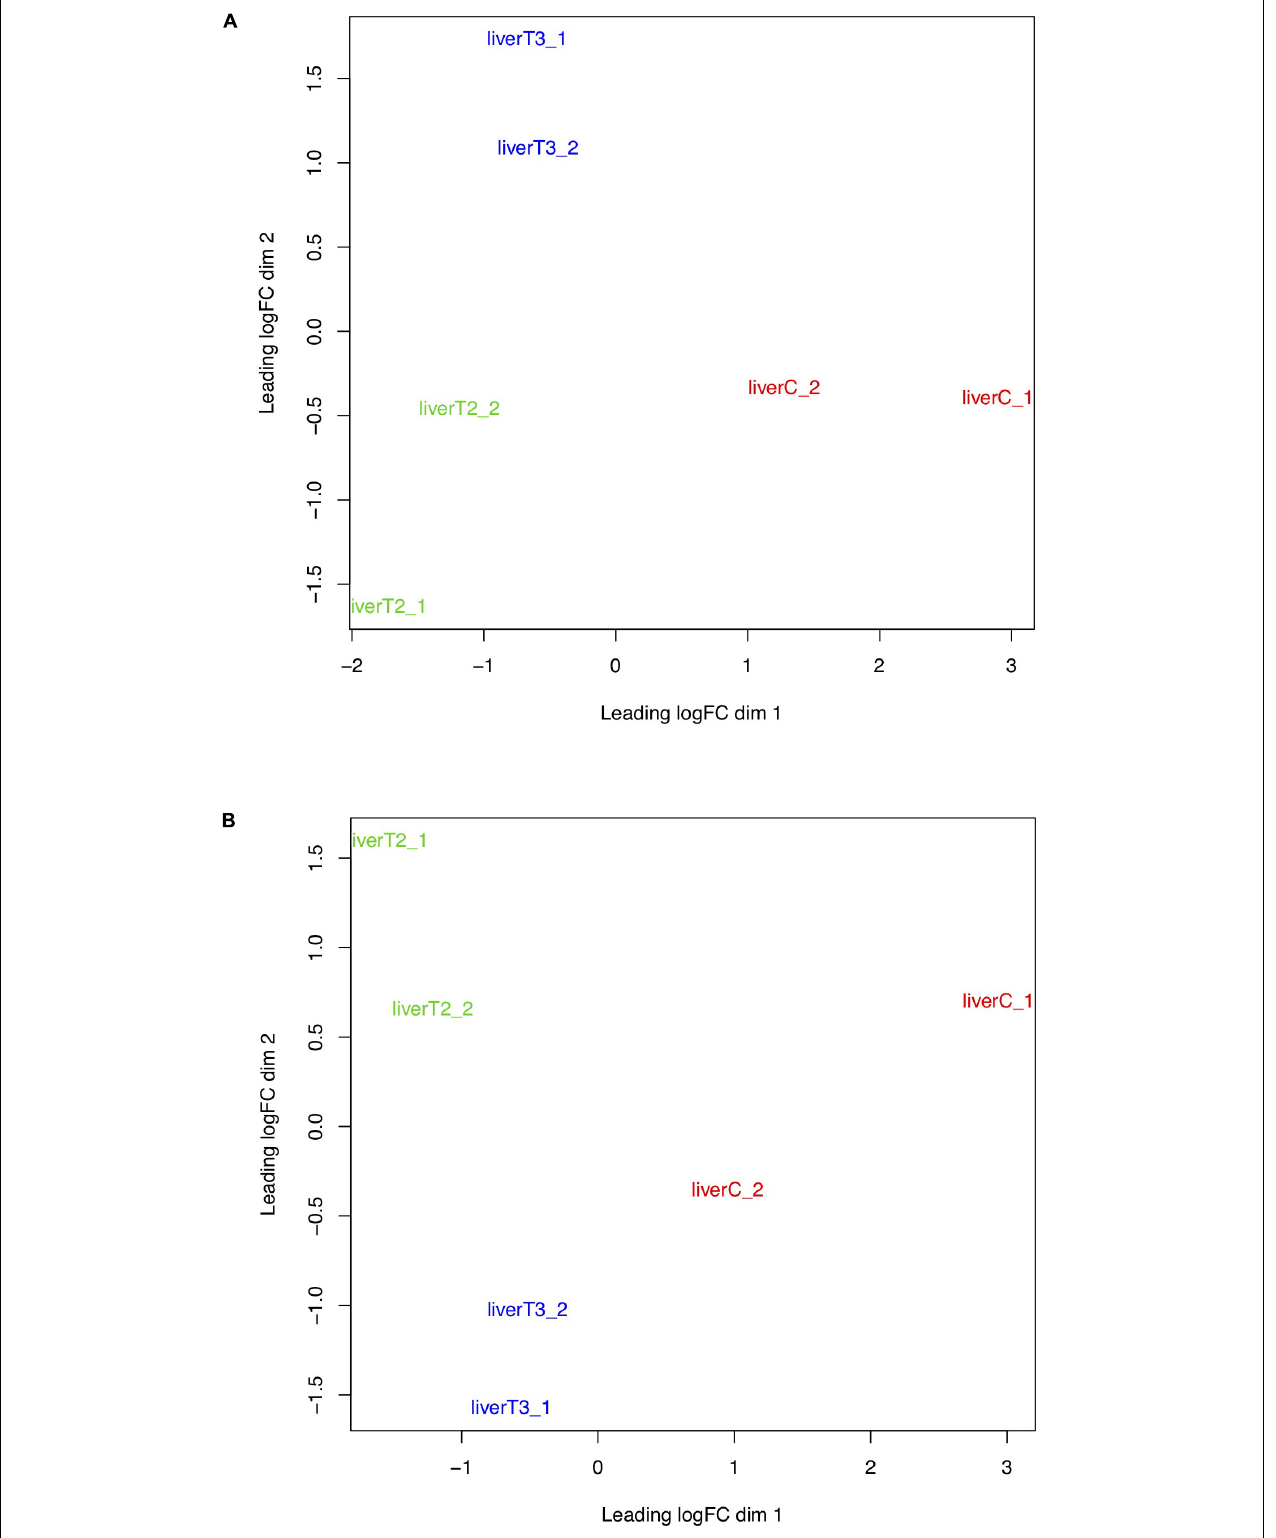
FIGURE 6 | MDS plots. Groups of samples can be analyzed using Multi-dimensional scaling (MDS) plots where the distance between samples and conditions reflect their similarity. (A) log2 normalized counts. (B) TMM normalized counts.